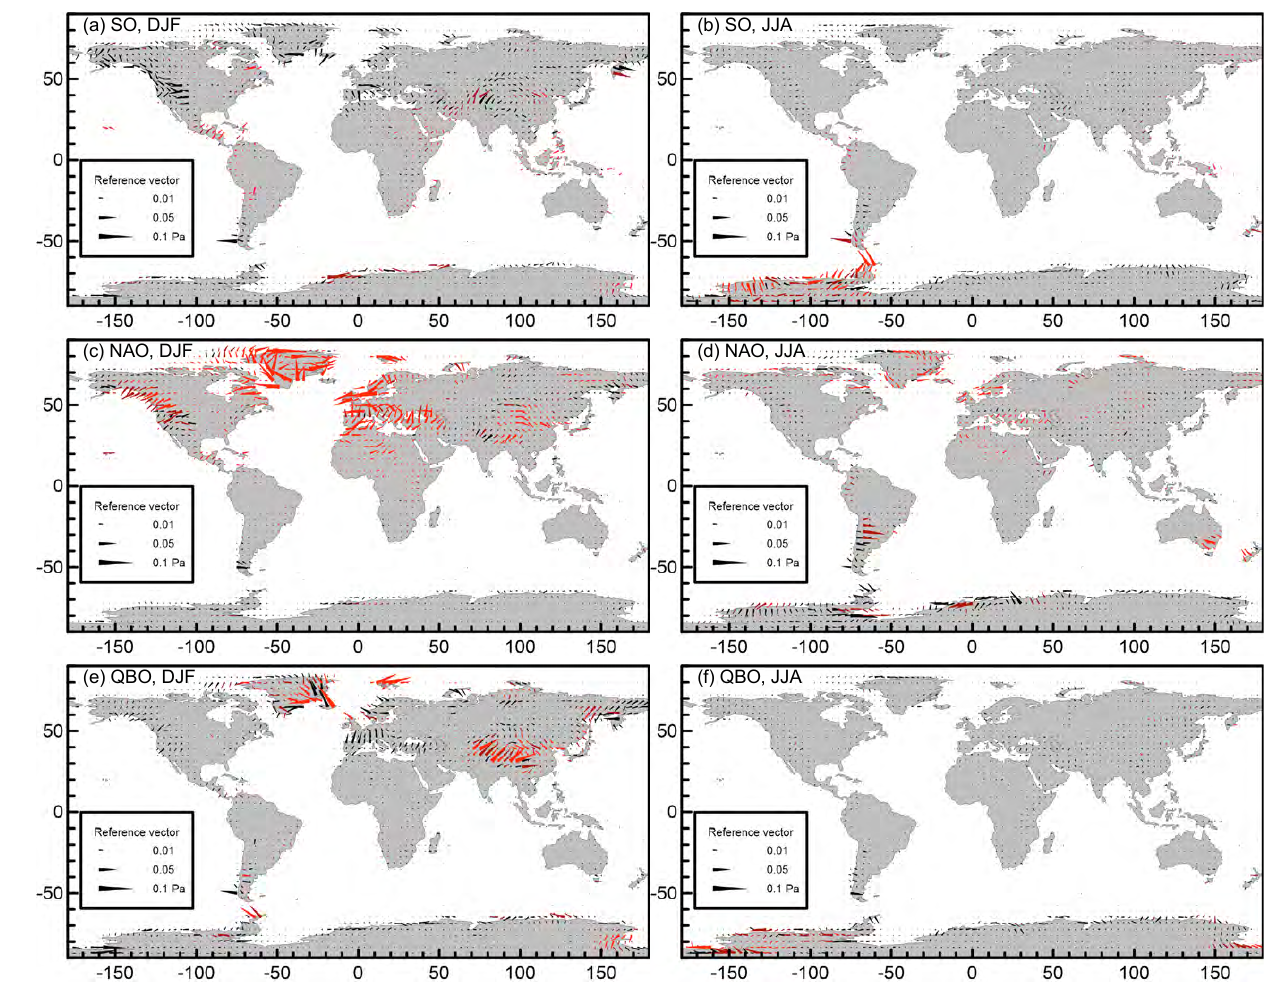
Figure 10. Response of the orographic GW momentum fluxes (Pa) at the 850hPa level related to the activity of the Southern Oscillation (a, b) , North Atlantic Oscillation (c, d) and quasi-biennial oscillation (e, f) during DJF (a, c, e) and JJA (b, d, f) seasons. The responses correspond to the increase in the oscillation index by 4 times its SD, i.e., to the transition of the respective oscillation from a highly negative to a highly positive phase; red symbols pertain to locations with at least one orographic GW flux component response statistically significant at the 95% confidence interval. Analysis period: 1979–2010, monthly